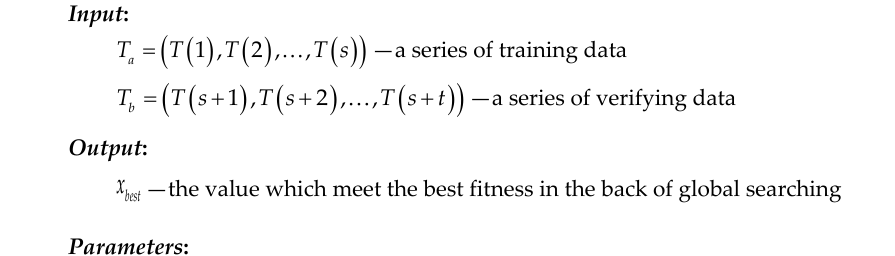
Algorithm 1 Moth-Flame Optimization